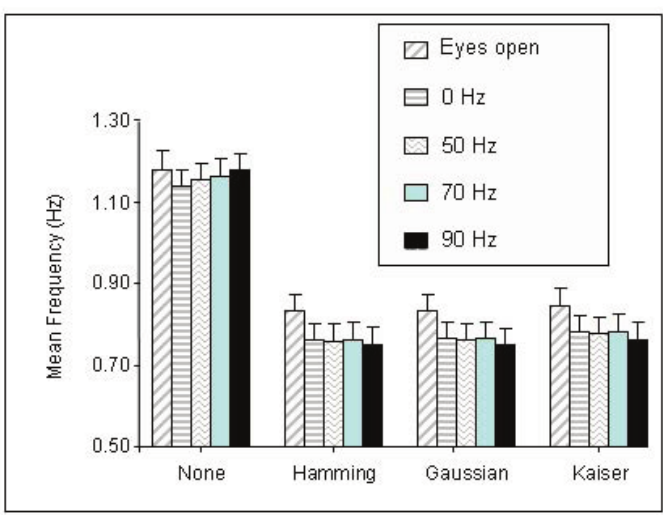
Figure 10. Mean frequency estimation using Fourier–Bessel Expansion for 200-point win- dows (ML): (a) No window; (b) Hamming window, (c) Gaussian window ( (cid:5) D 2:5 ), (d) Kaiser window ( ˇ D 8